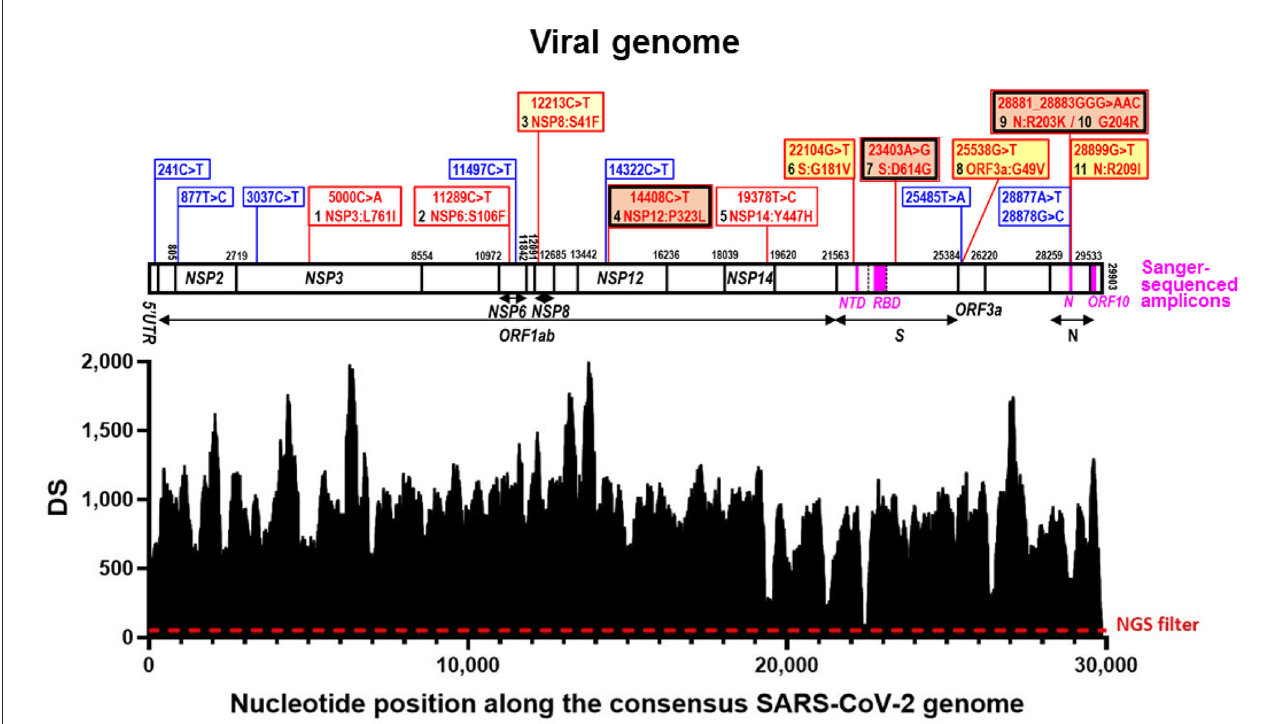
FIGURE1 Deepness of sequencing (DS) along the viral genome and sequence variations identified. In the l ower part, SARS-CoV-2 genomic coverage obtained by next-generation sequencing (NGS). The horizontal axis corresponds to positions in the SARS-CoV-2 Wuhan-Hu-1 consensus genome sequence (GenBank ID: NC_045512.2) and the vertical one to the depth of the sequence (DS) at a given position. The dashed horizontal line marks the NGS filter (DS ≥ 50). Above this, aligned over the nucleotide positions, the viral genome is schematized as a horizontal bar, with identification of the genes hosting nucleotide substitutions in our reported genome. Gene boundaries are marked with vertical lines crossing the bar, giving their corresponding nucleotide position in the sequence. Gene names are inscribed into the bar or placed under it, with indication with horizontal short lines or double-pointed arrows, of their spans (including the one of ORF1ab , which is a polyprotein-encoding gene). The part of the S gene that encodes the Receptor Binding Domain (RBD) is marked within the genome bar using transversal broken lines to indicate its boundaries. The amplicons used in Sanger sequencing (Table 1) are marked as magenta-colored rectangles within the genome bar, with their abbreviated names given below in magenta. Blue and red vertical lines emerging up from the genome bar, respectively, mark synonymous and non-synonymous sequence variants, described in the corresponding banners (equally colored). For non-synonymous changes the banners inscribe the nucleotide change (nucleotide numbering is that for the complete genome) and the amino acid substitution (amino acid numbering is that for the sequence of the mature protein), also numbering in black the amino acid changes from 1 to 11 as they occur along the genome from 5 ′ to 3 ′ . A double frame in black and red indicates that the amino acid change belongs to the canonical set for the B.1.1. lineage. The background color of the banner is orange for amino acid changes reported in millions of sequences, deep yellow for tens of thousands, light yellow for thousands, and white for smaller numbers. These numbers are given in Table